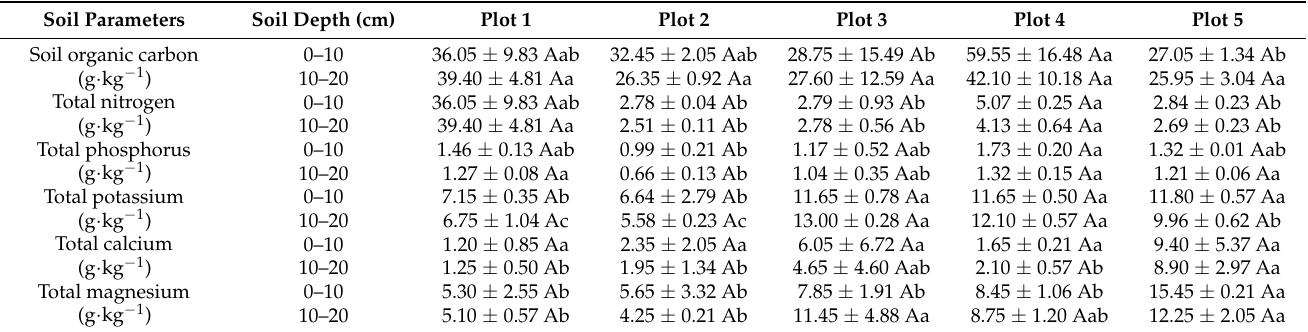
Table 2. Soil total nutrients of Z. planispinum plantation in different planting